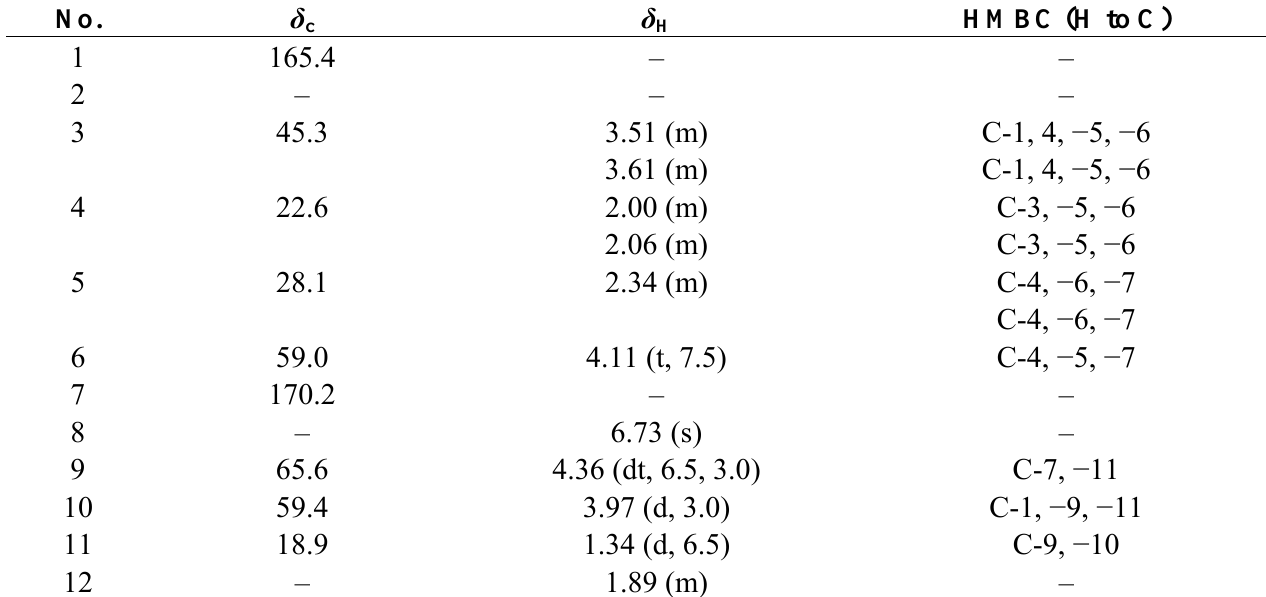
Table 1. 1 H- (500 MHz) and 13 C-NMR (125 MHz) data of compound 1 (in CDCl ppm, J in